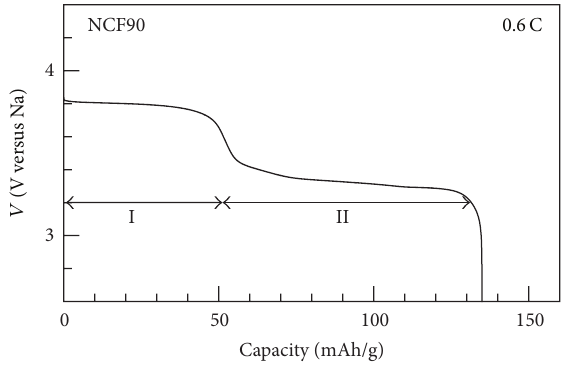
Figure 19: OCV discharge curves of NCF90 film against Na mea- sured at 0.6C. For convenience of explanation, we define plateaus I and II (cited from [15]).